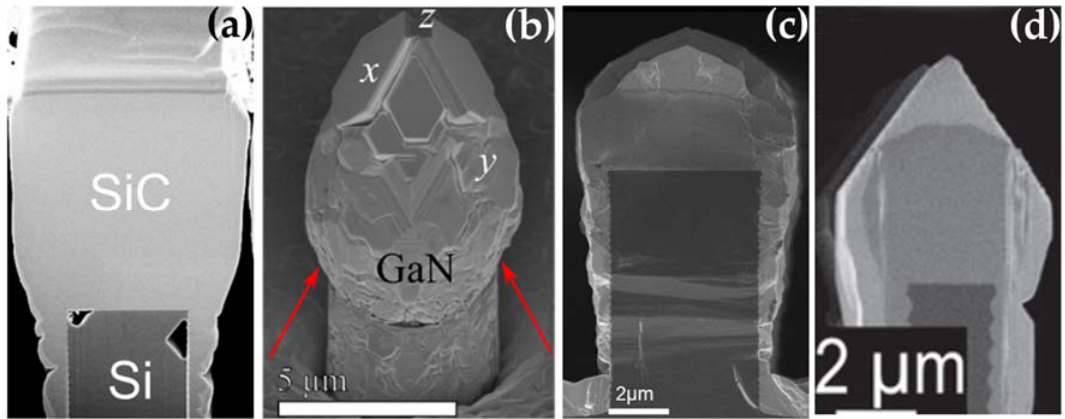
Figure 5. Deposition of several different materials on Si pillars. ( a ) SiC/Si, deposited by hot-wall Chemical Vapour Deposition. Reproduced with permission from [24]. Electrochemical Society ( b ) GaN/Si, deposited by plasma-assisted molecular beam epitaxy. Reproduced with permission from [25]. American Chemical Society ( c ) GaAs/Si, deposited by molecular beam epitaxy. Reproduced with permission from [26]. Copyright 2013, the American Institute of Physics ( d ) GaAs/Ge/Si, where Ge was deposited by LEPECVD and GaAs by metal-organic vapour-phase epitaxy. Reproduced with permission from [28]. American Institute of Physics.